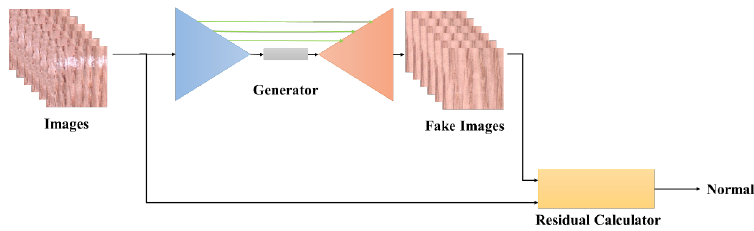
Figure 3. Detection process of the proposed method.